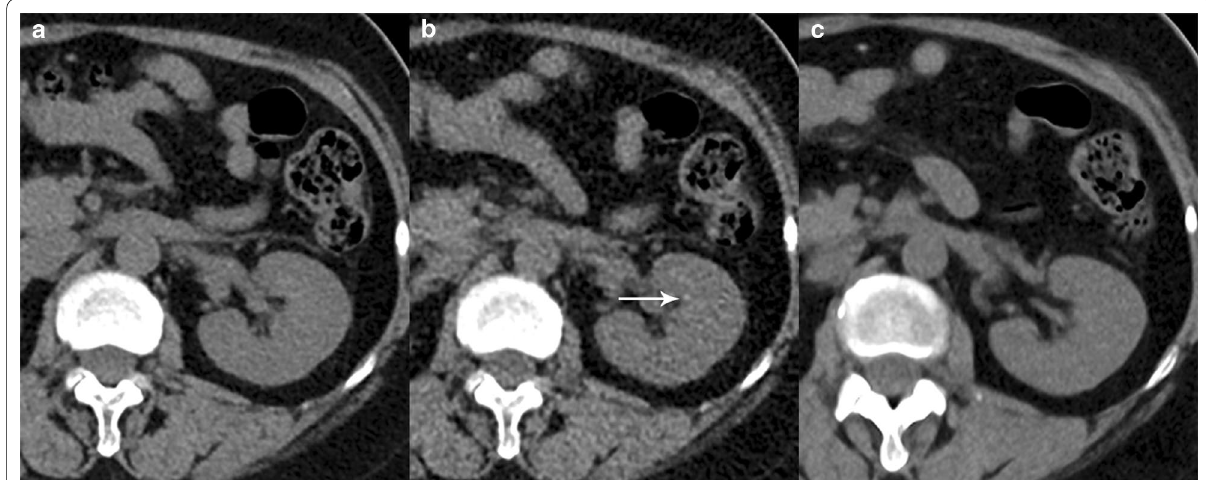
Fig. 4 CT images from a 57-year-old male patient with a clinically suspected renal calculus. A left renal calyceal calculus 1.6 mm in the diameter could be seen on the ULD-HIR ( b ) image but not on the LD-HIR ( a ) or ULD-DLR ( c ) images. With LD-HIR imaging used as the gold standard, the stone was a false positive. LD-HIR means low-dose computed tomography with hybrid iterative reconstruction. ULD-HIR means ultra-low-dose computed tomography with hybrid iterative reconstruction. ULD-DLR means ultra-low-dose computed tomography with deep learning reconstruction